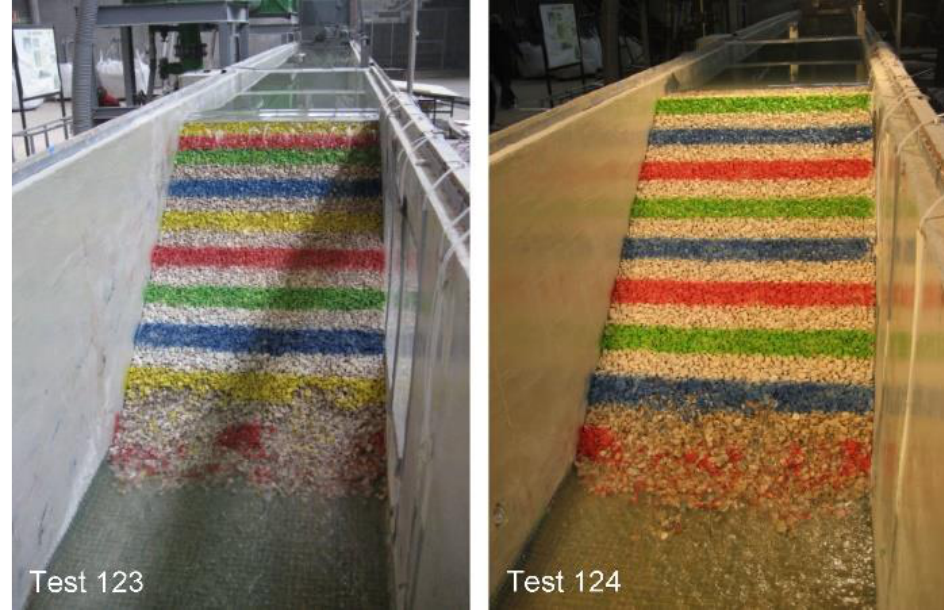
Figure 17. Failure progress in tests nº 123 and 124 for a discharge of roughly 0.0090 m 3 s −1 .